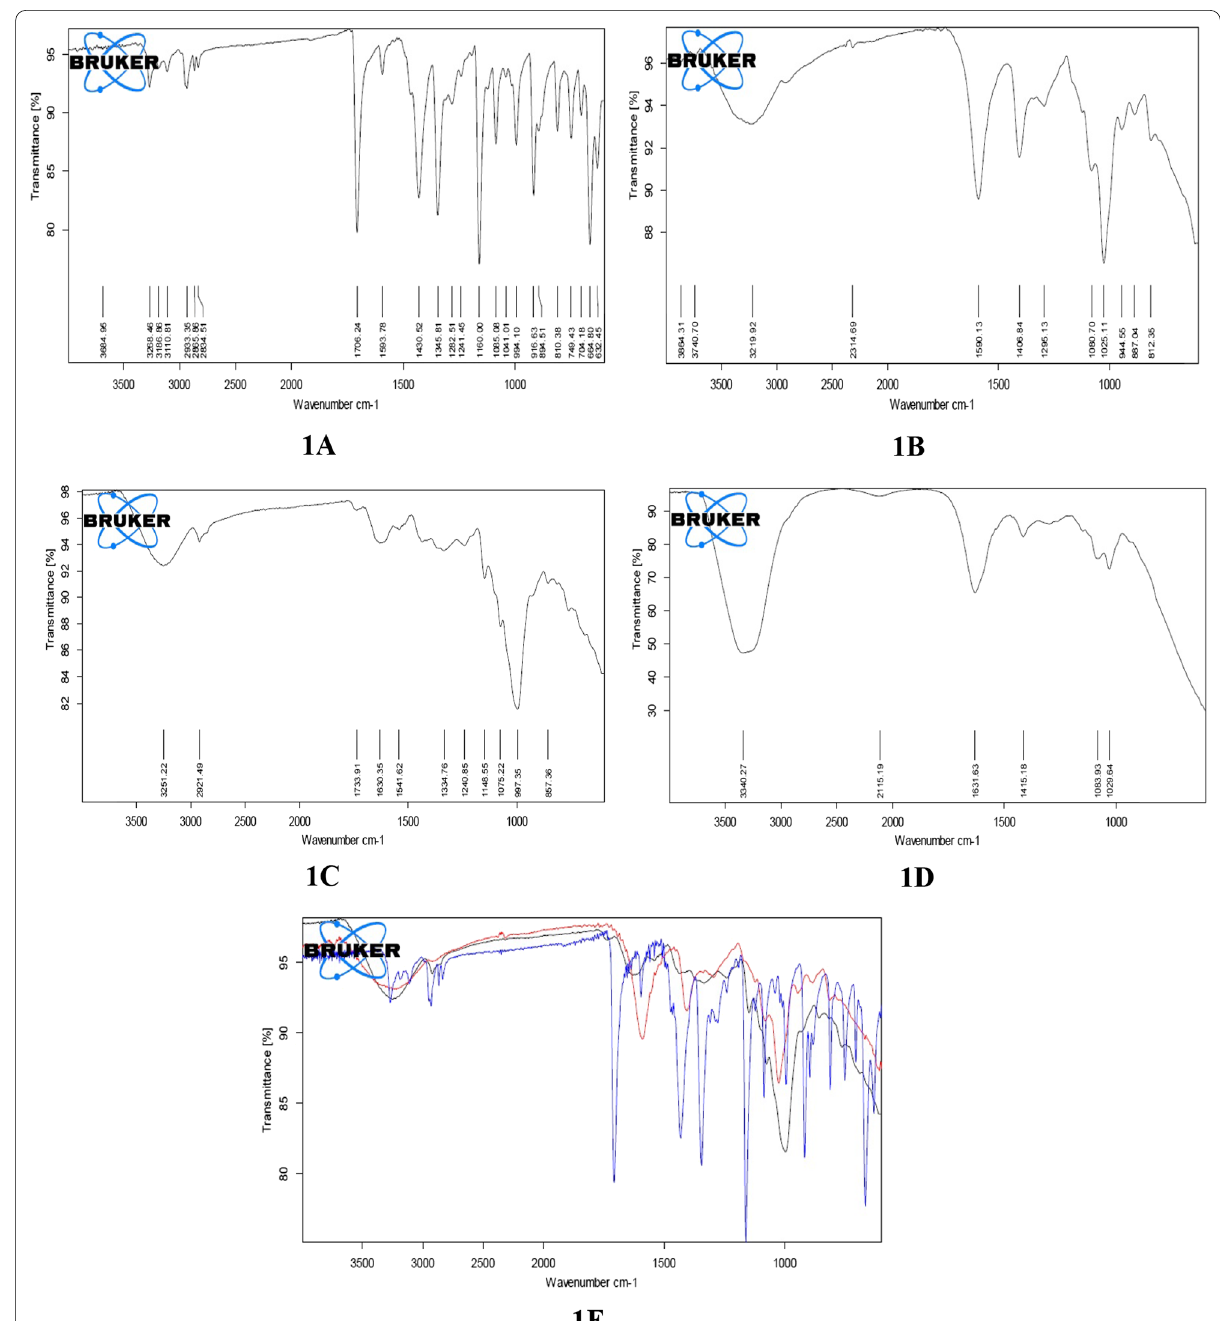
Fig. 1 The FTIR-spectra are shown here. The spectra obtained after scanning from 4000 to 400 cm − 1 and maintaining the resolution at 4 cm − 1 show the presence of prominent functional groups A FTIR—spectra of pure gliclazide B FTIR—spectra of sodium alginate C FTIR—spectra of starch of Musa balbisiana species D FTIR—spectra of drug-loaded microsphere E overlap FTIR—spectra of pure drug, starch and sodium